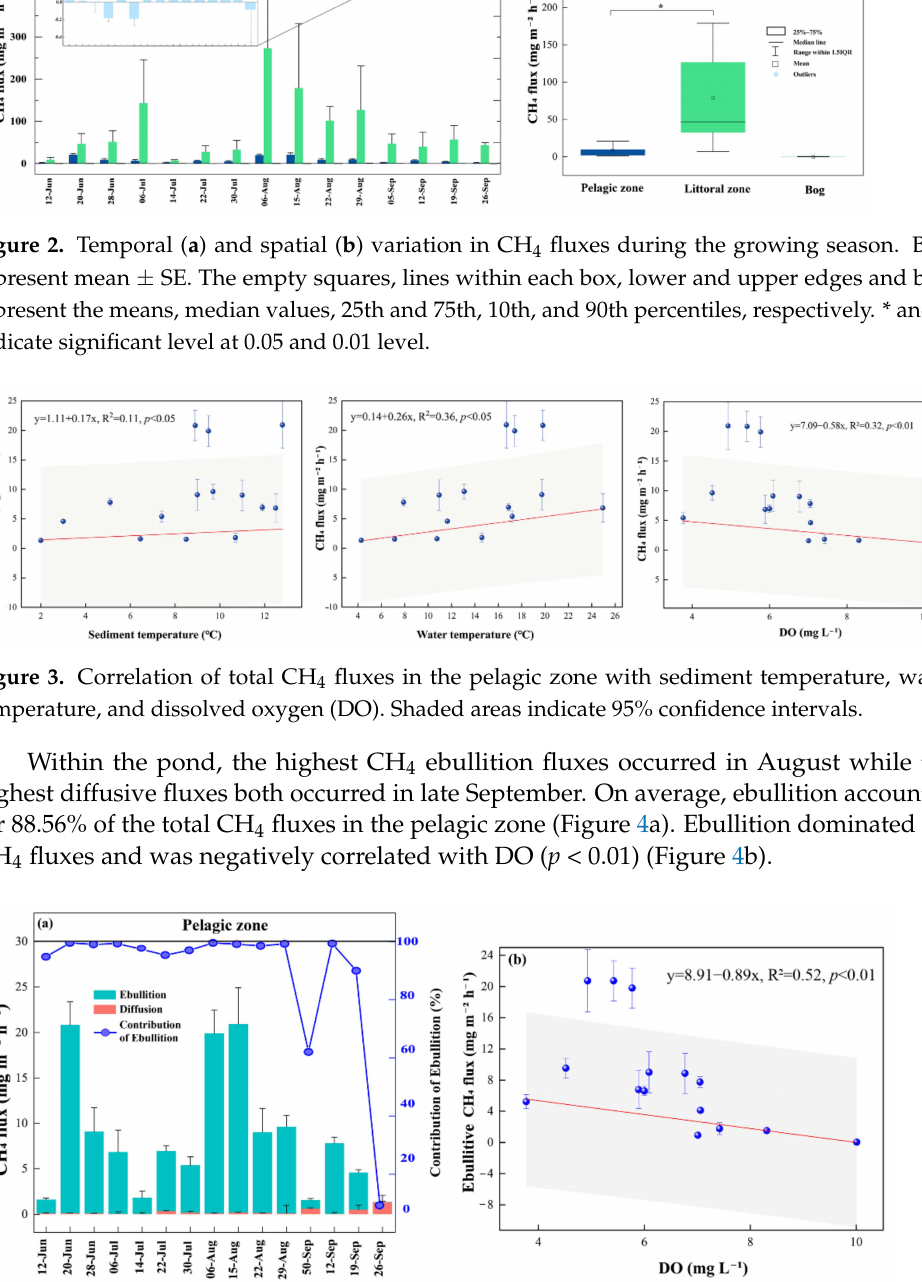
Figure 4. Contribution of CH 4 ebullition fluxes, diffusive fluxes in pelagic zone. The bars indicate the CH 4 fluxes and the line indicates the contribution of ebullition ( a ). Correlation of CH 4 ebullition fluxes in the pelagic zone with dissolved oxygen (DO). Shaded areas indicate 95% confidence intervals ( b